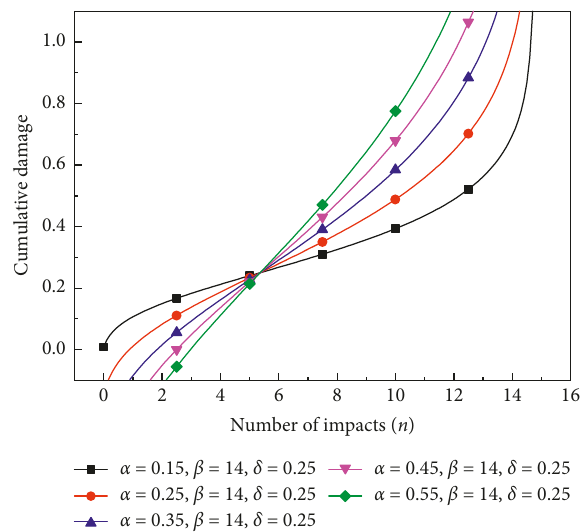
Figure 9: Influence of α to the model curve.